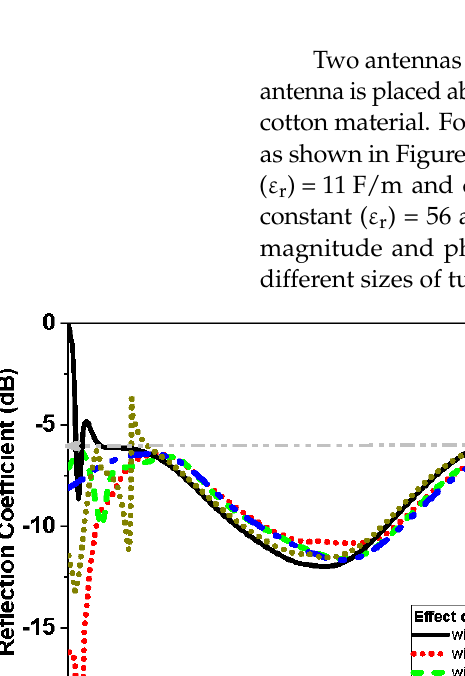
Figure 14. The layers model of breast with and without tumor tested using ( a ) one antenna and ( b ) two antennas.